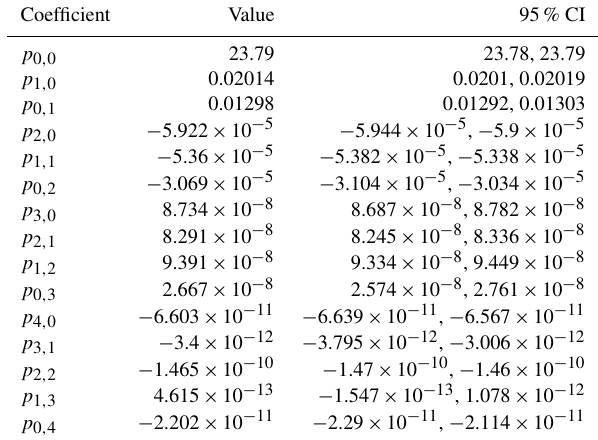
Table A1. Coefficients of the fourth-order polynomial surface de- scribing the vignetting